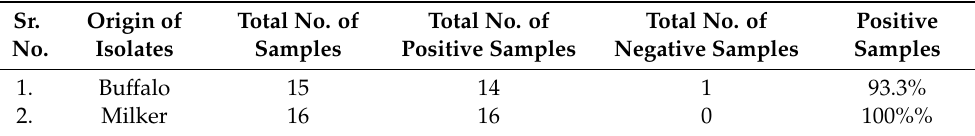
Table 3. Results of molecular identification of S. aureus isolates from buffalo and milkers.